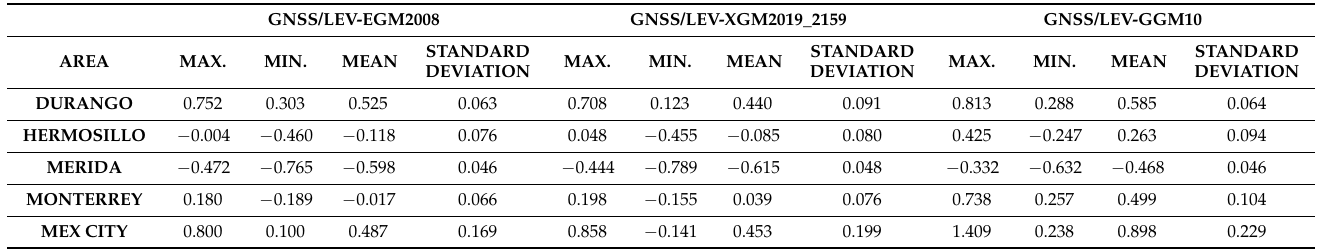
Table 1. Statistics of Geoid undulation differences between the geoid models (EGM2008, XGM2019e_2159, and GGM10), and GNSS/leveling stations for five Mexican urban areas. Units: Meters.